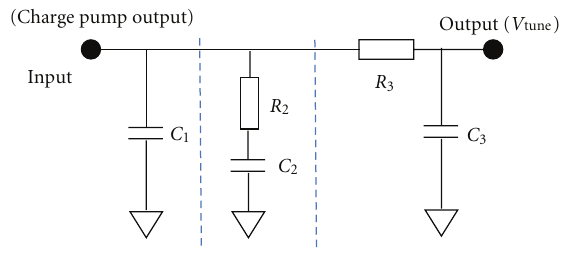
Figure 3: Loop filter schematic.